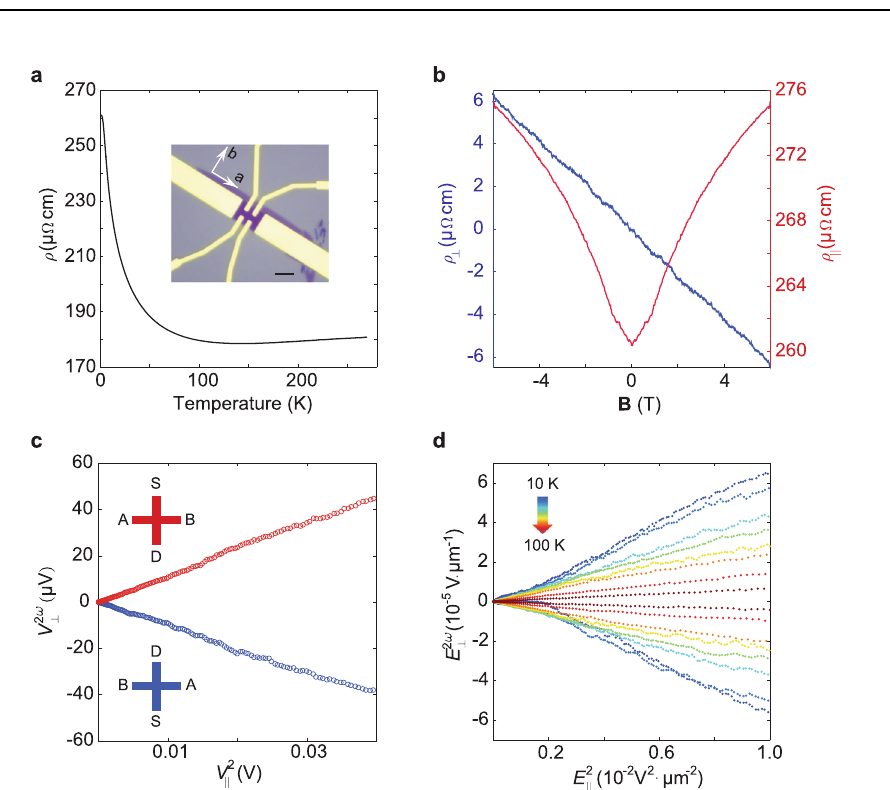
Fig.3|CalculatedelectronicbandstructureandBerrycurvatureofbilayerand trilayer MoTe 2 . a , b Band structure of the MoTe 2 T d bilayer ( a ) and trilayer ( b ), respectively. The small triangle in a indicates k x =0 : 2034 2 π a through which the bandpathofinsetpasses.Theinsetin a showthecrossingpointsinthebandsalong the path connecting two points ð 0 : 2034 2 π a ,±0 : 0228 2 π b Þ which is perpendicular to ΓΧ line.Thesmallcirclein b indicatesthe anti-crossing pointthat ismagni fi ed in b . c – f ( c ) and ( e ) shows Berry curvature (z-component) distribution in momentum space at speci fi c energy levels (0.28 and 0.24eV) for MoTe 2 bilayer and trilayer,